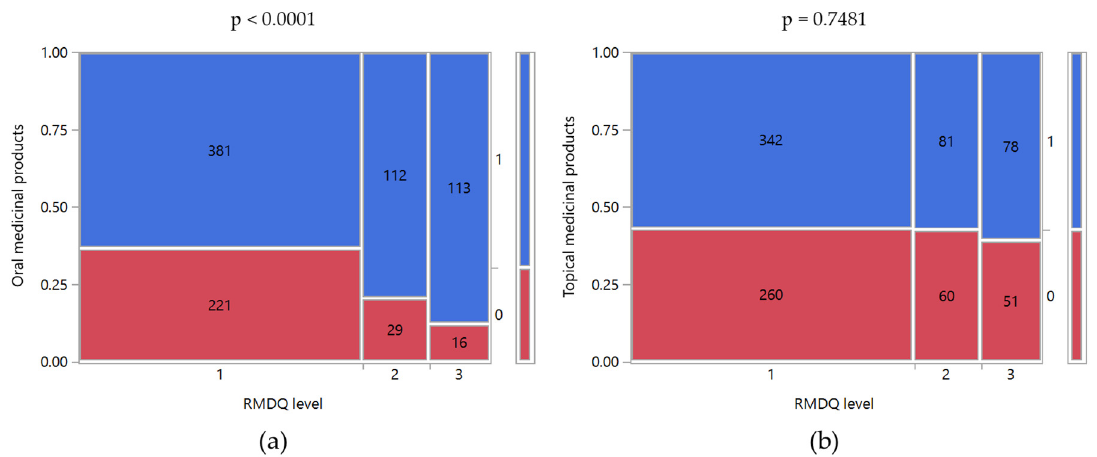
Figure 4. Mosaic plots of patients’ taking of ( a ) oral and ( b ) topical medicinal products to manage LBP versus RMDQ level. Taking of Oral/Topical medicinal products: 0, no; 1, yes. RMDQ levels: 1, low; 2, medium; 3, high. The class counts were reported inside the mosaic plots. Above the graph is the p- value of Pearson’s chi-squared test between the two